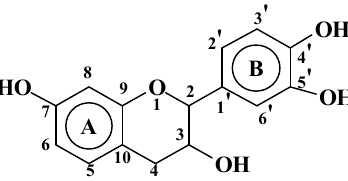
Scheme 1. Sites numbering of a flavonoid unit.